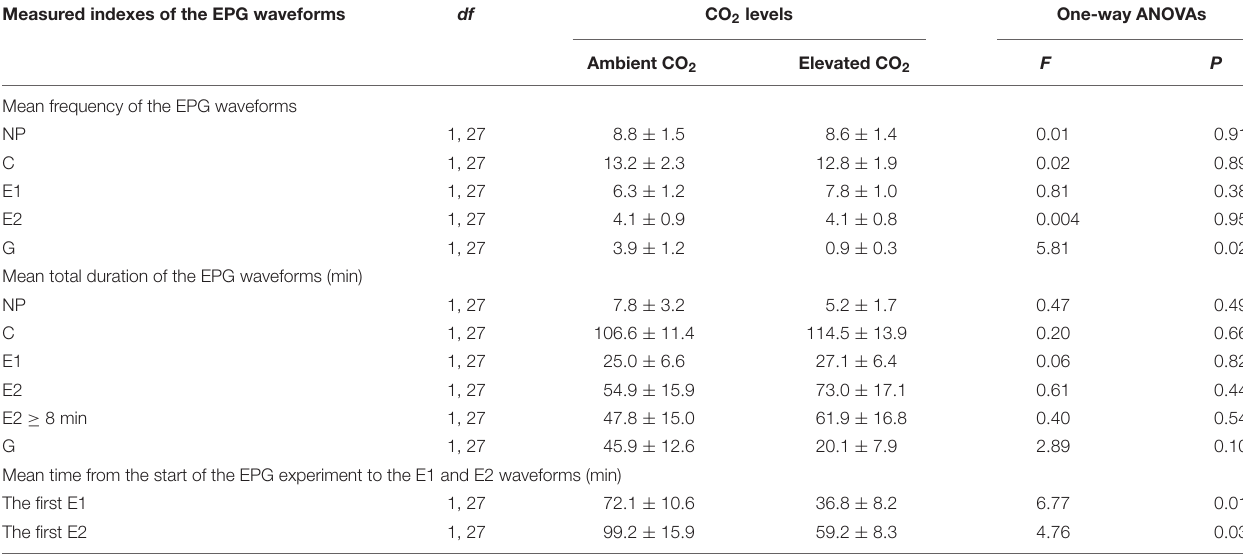
FIGURE 3 | Kaplan–Meier survival curves of Aphis gossypii fed on the cotton plant under different CO 2 levels (ambient vs. elevated) (The significant difference between the treatments of ambient and elevated CO 2 were obtained by log-rank test at P < 0.05). TABLE 5 | Mean ( ± SE) values of the feeding behavior parameters of the cotton aphid A. gossypii fed on fully expanded leaves excised from the 35- to 60-day-old cotton seedlings grown under ambient and elevated CO 2